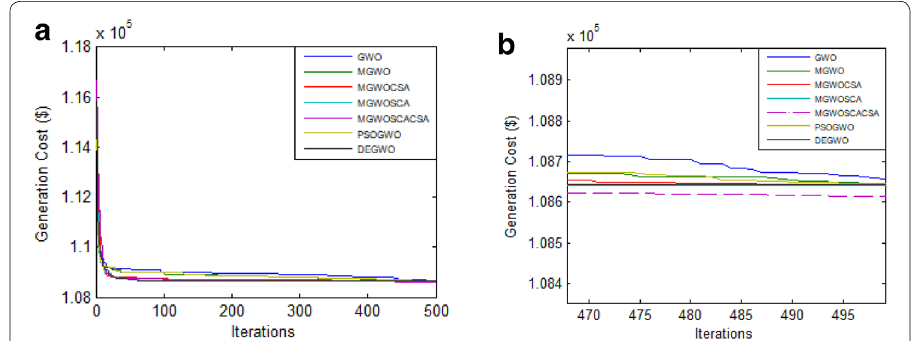
Fig. 11 a Convergence curve characteristics for EED in Case 3 with uncertainty in wind and load profile. b Magnified to differentiate the proposed algorithm